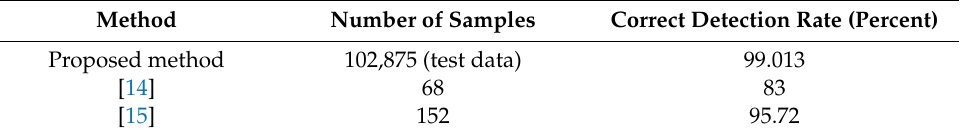
Table 8. Comparison of the results obtained in this study with two other